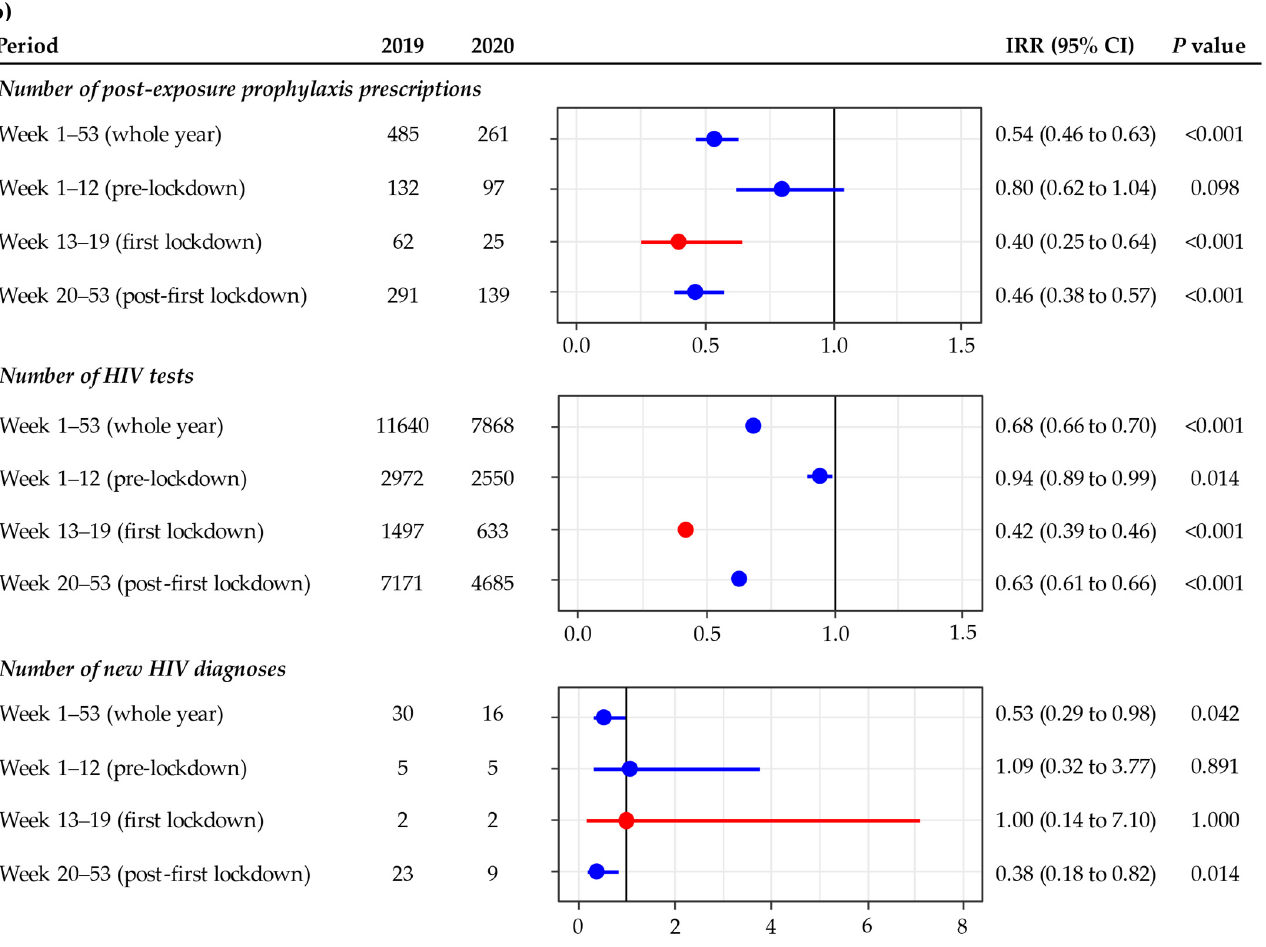
Figure 1. Incidence rate ratio of the number of HIV post-exposure prophylaxis prescriptions, HIV tests, new HIV diagnoses in 2020 compared to 2019 at the ( a ) Melbourne Sexual Health Centre and ( b ) Sydney Sexual Health Centre. The red dots and lines represent the lockdown periods.